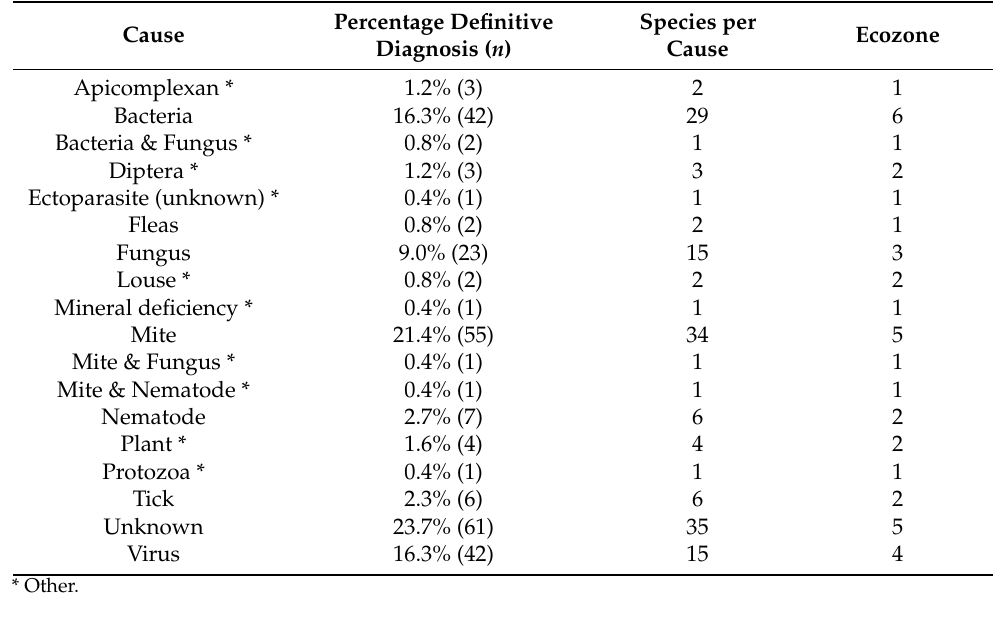
Table 2. Overall proportion of causes of dermatitis in terrestrial and semi-aquatic mammalian wildlife.